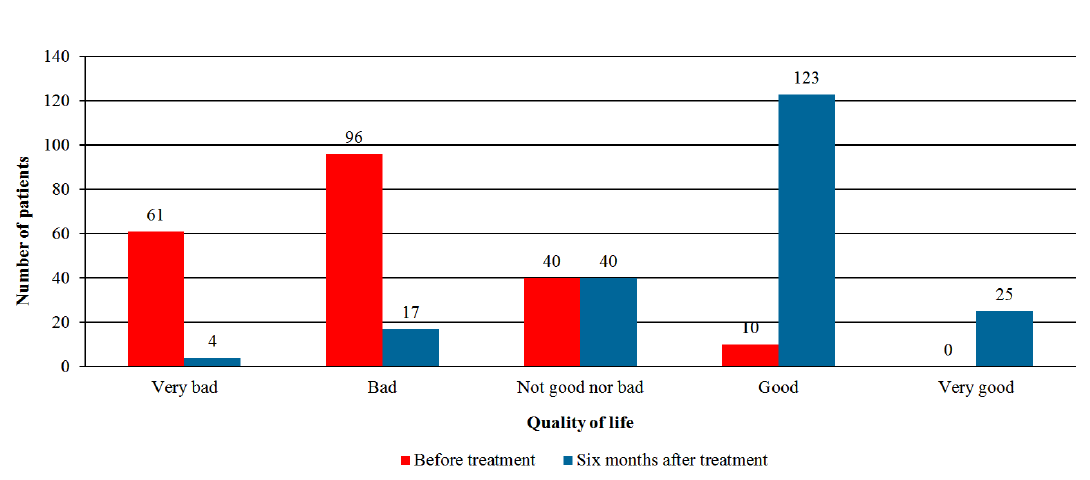
Figure 4. Quality of life prior and six months after the initiation of cannabis treatment ( p < 0.001).